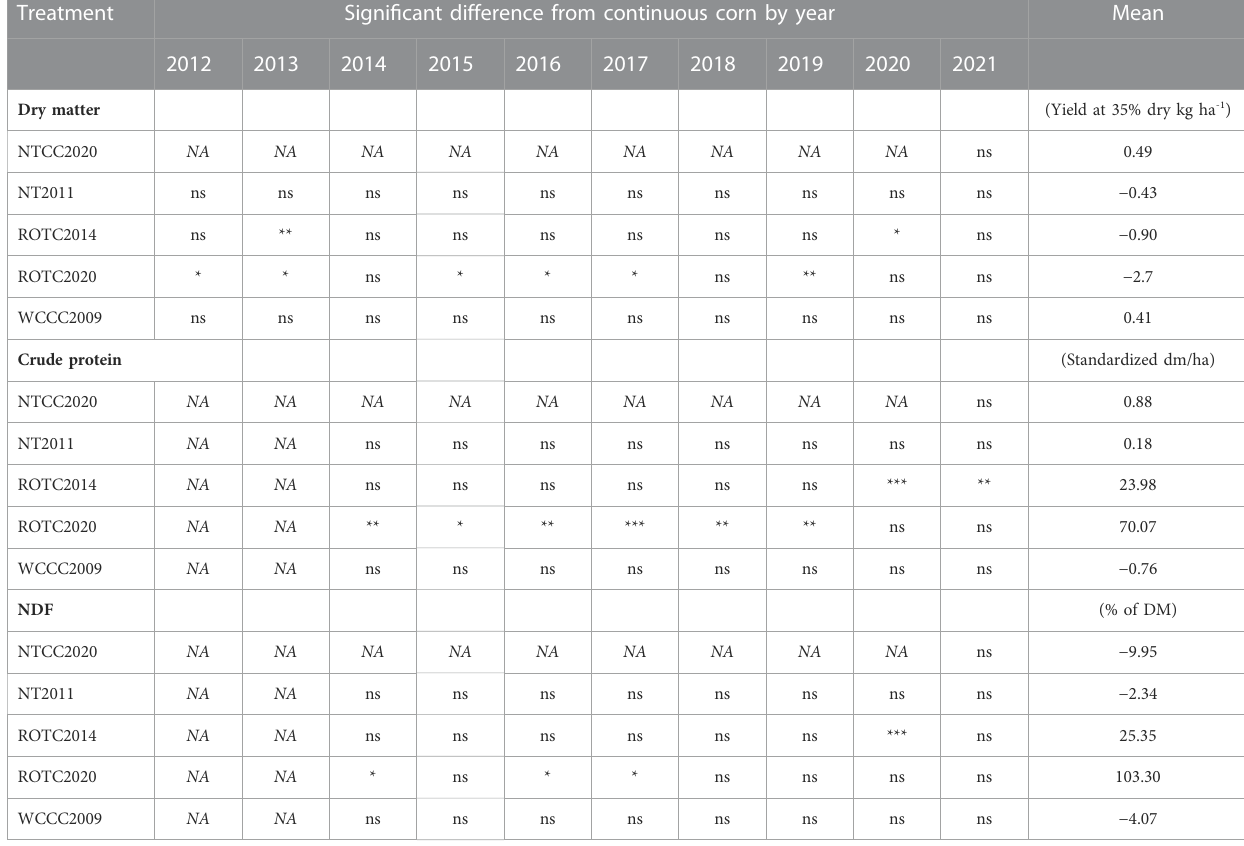
TABLE 6 Signi fi cance level of post hoc Holm corrected pairwise t -test comparisons with continuous corn treatment over time for yield variables with signi fi cant time:treatment interactions. NA is no data for that year, ns is not signi fi cant, * is signi fi cant to 0.05, ** is signi fi cant to 0.01, and *** is signi fi cant to 0.001 or less. Mean values over the entire timeframe are in the farm right column. Treatment Signi fi cant difference from continuous corn by